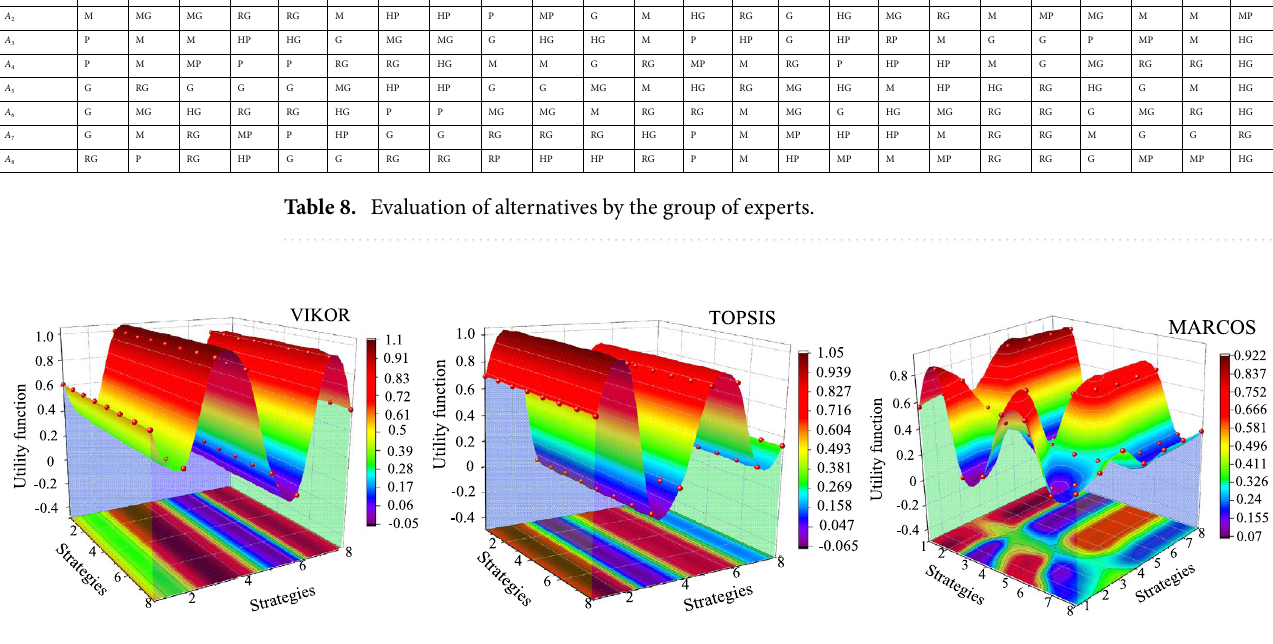
Figure 6. Three dimensional distribution of utility function values of three